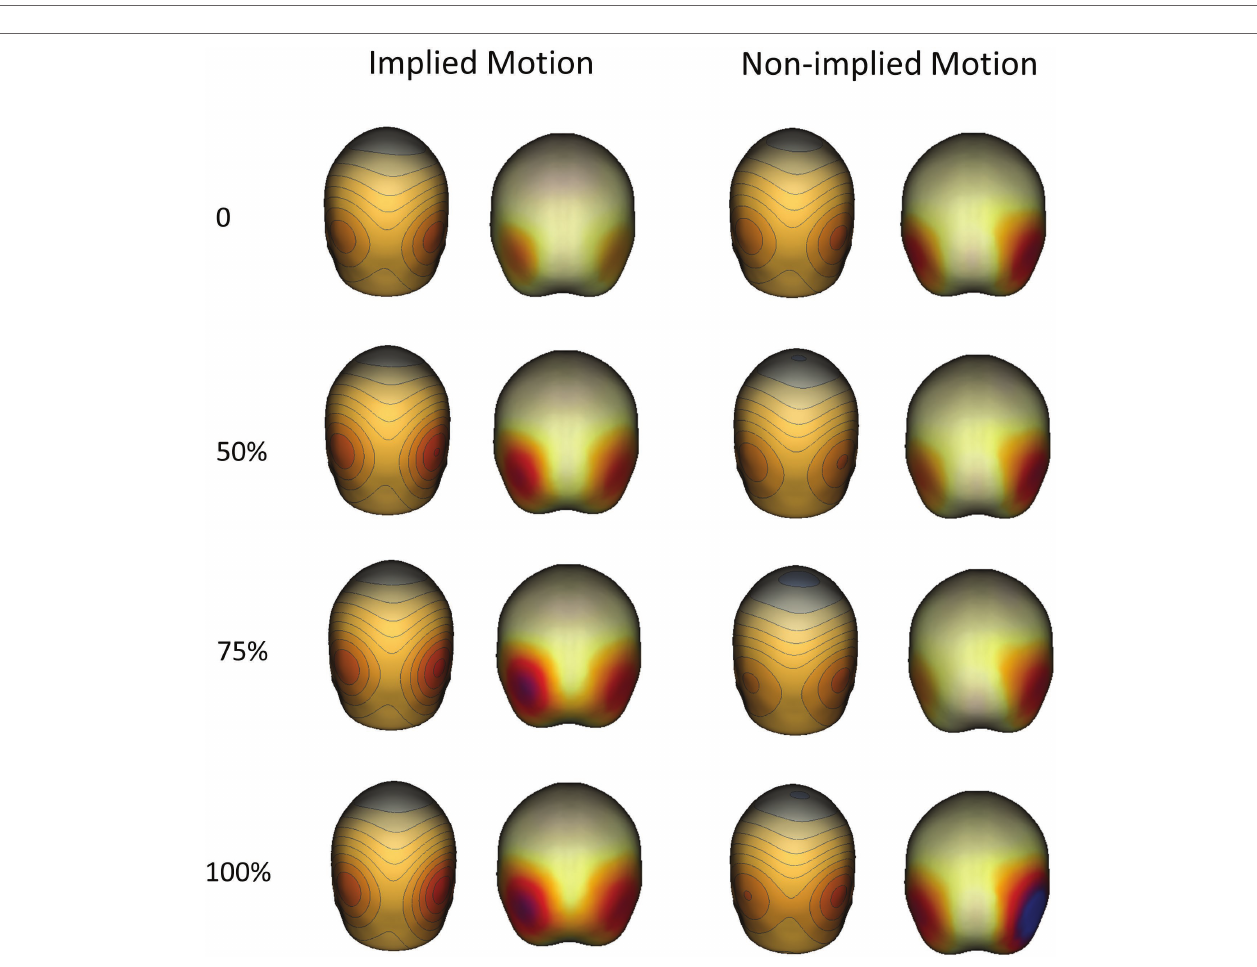
FIGURE 3 | Global field power (GFP) plots of N1 and P2 components (M ± SE) evoked by implied motion (IM) pictures and non-implied motion (non-IM) pictures at different coherence levels. * indicates p <